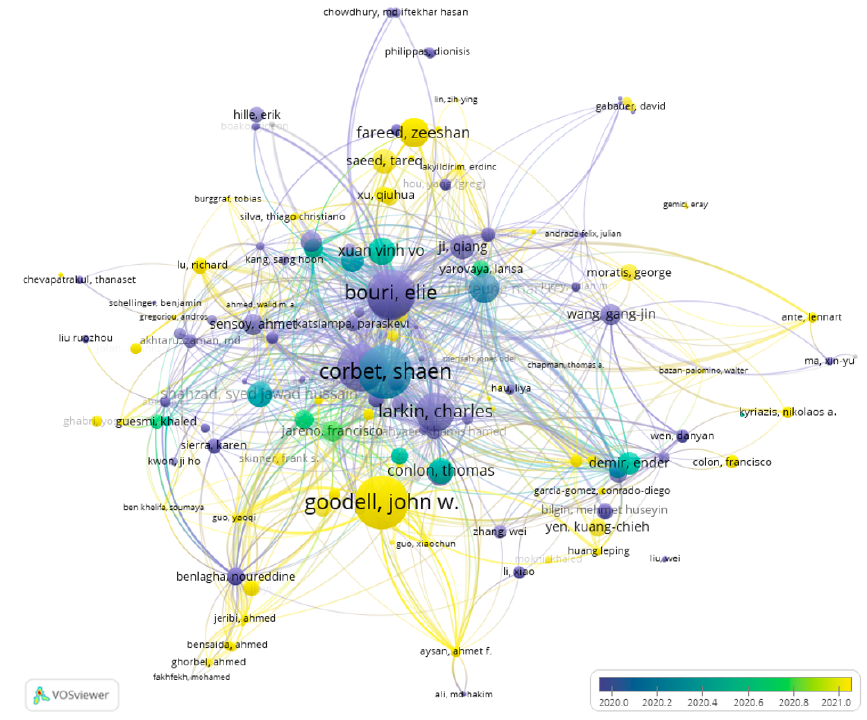
Figure 2. Normalized citations of authors by year.